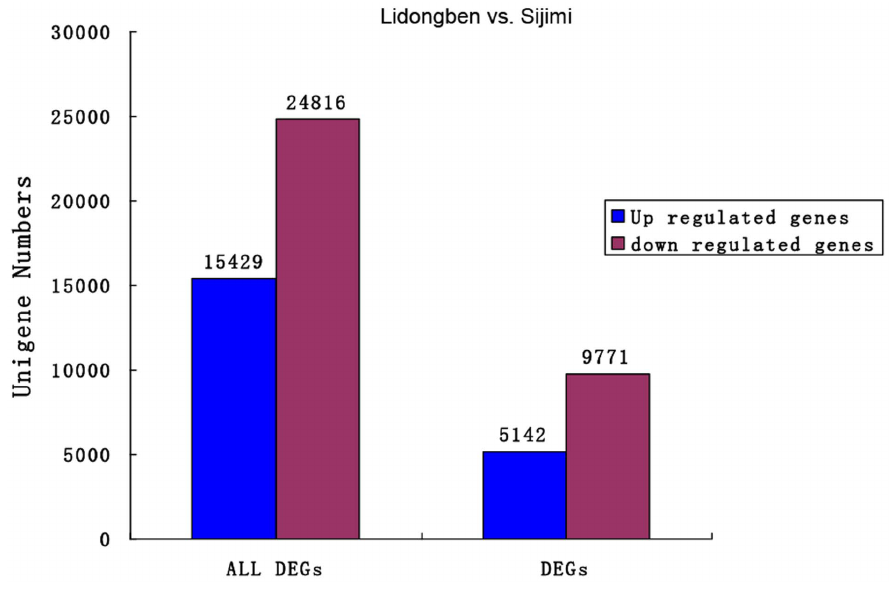
Figure 3. Differentially expressed genes between the ‘Lidongben’ and ‘Sijimi’. ‘ALL DEGs’ indicates those unigenes showing differential expression between the two samples, ‘DEGs’ indicates those unigenes with FDR # 0.001 and |log2Ratio| > 1. The numbers of genes up-regulated and down-regulated in the ‘Sijimi’ relative to ‘Lidongben’ are indicated above the blue or red bars,